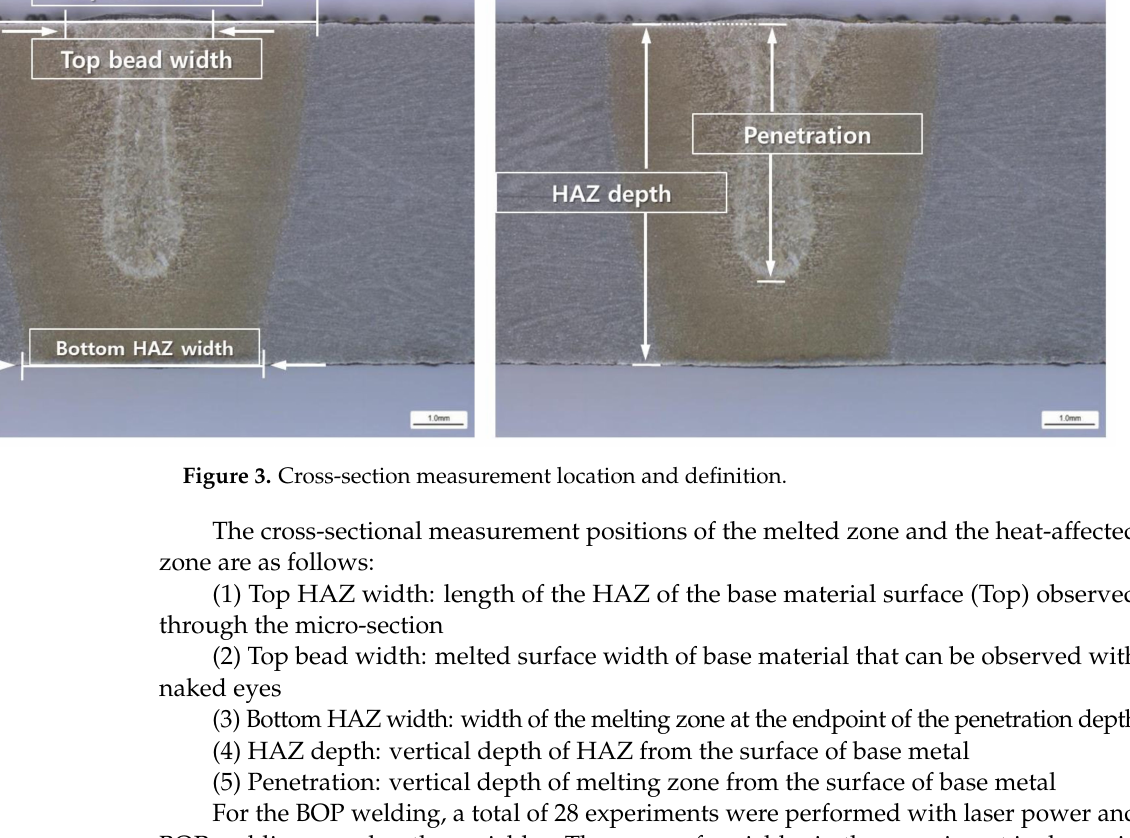
For the BOP welding, a total of 28 experiments were performed with laser power and BOP welding speed as the variables. The range of variables in the experiment is shown in Table 3